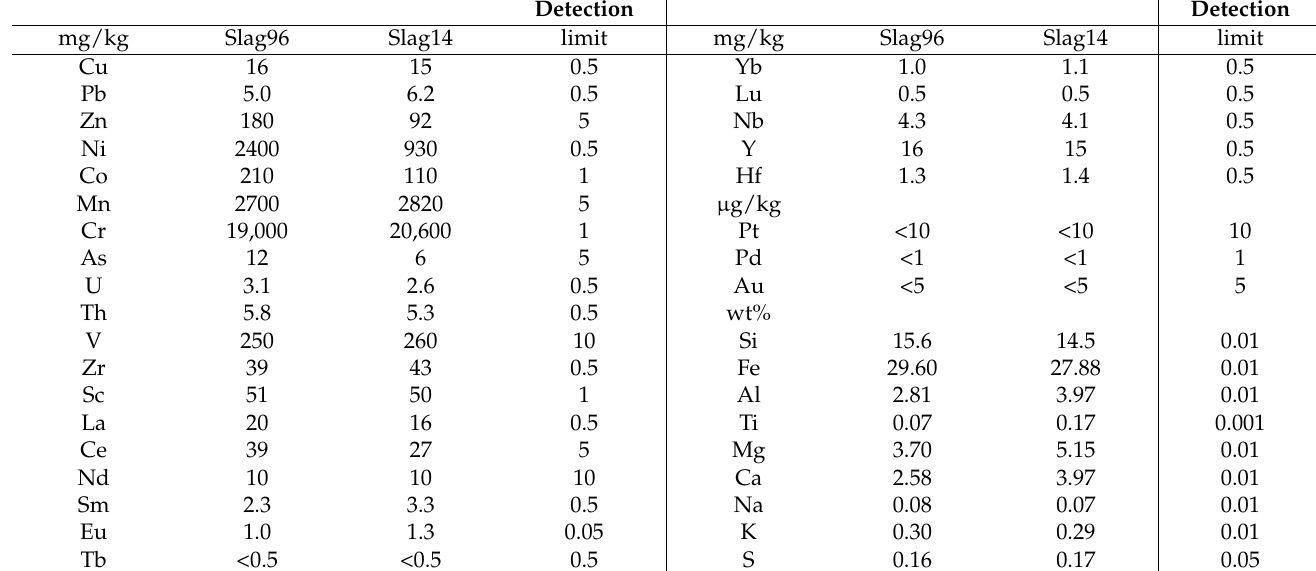
Table 6. Chemical composition of slag (smelting residue) from Fe–Ni–Co laterites, Larymna plant, Lokris. Detection